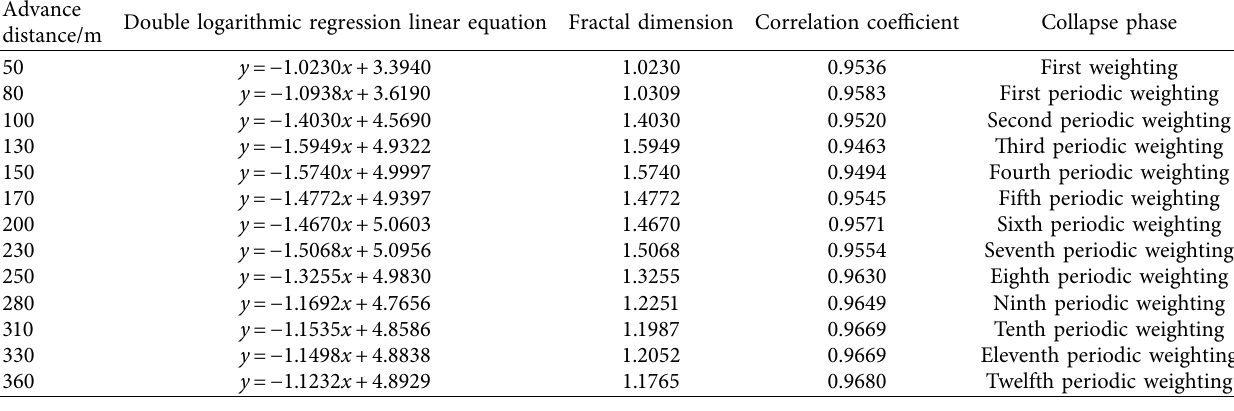
Table 3: Calculation of fractal dimension at different propulsion